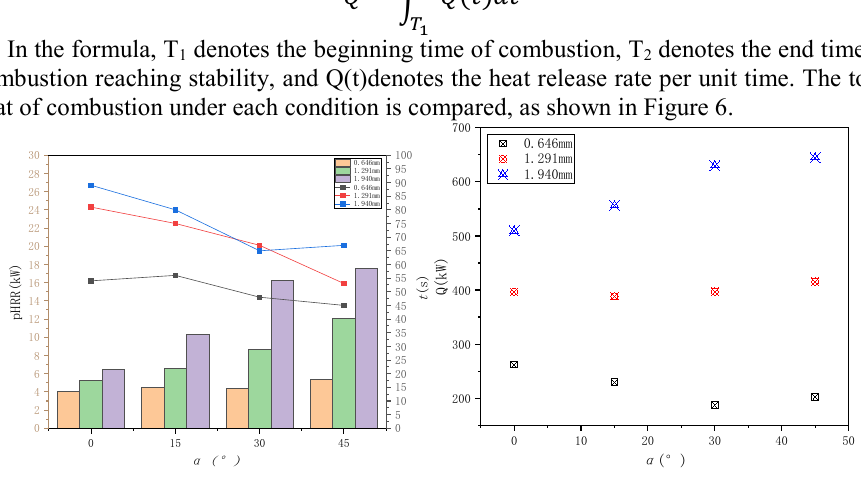
Fig. 5. Peak change of heat release rate. Fig. 6. Total heat of combustion